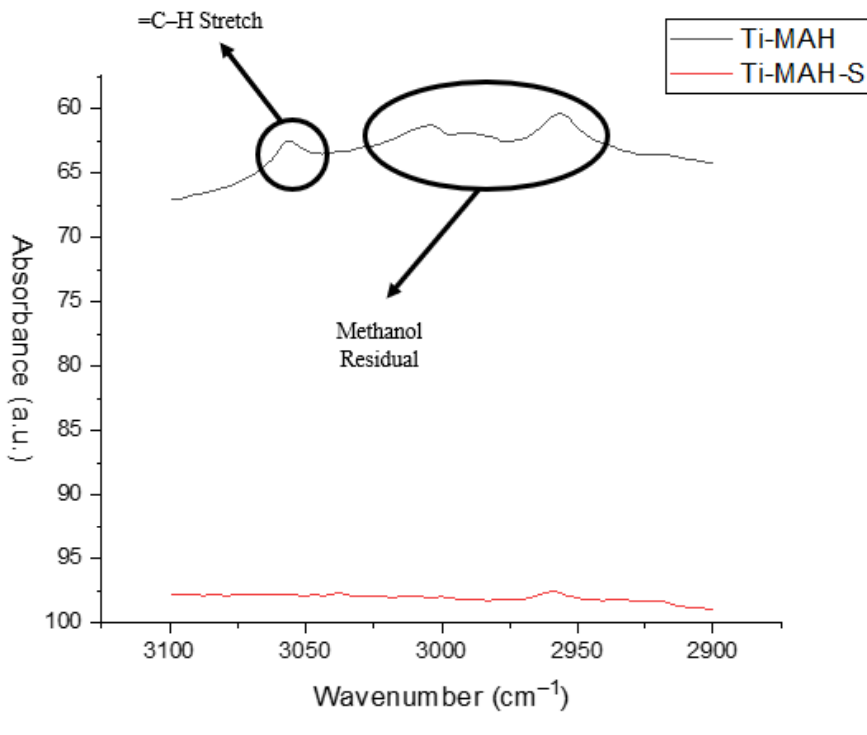
Figure 5. FTIR comparison of Ti-MAH and Ti-MAH-Si C-H stretch.